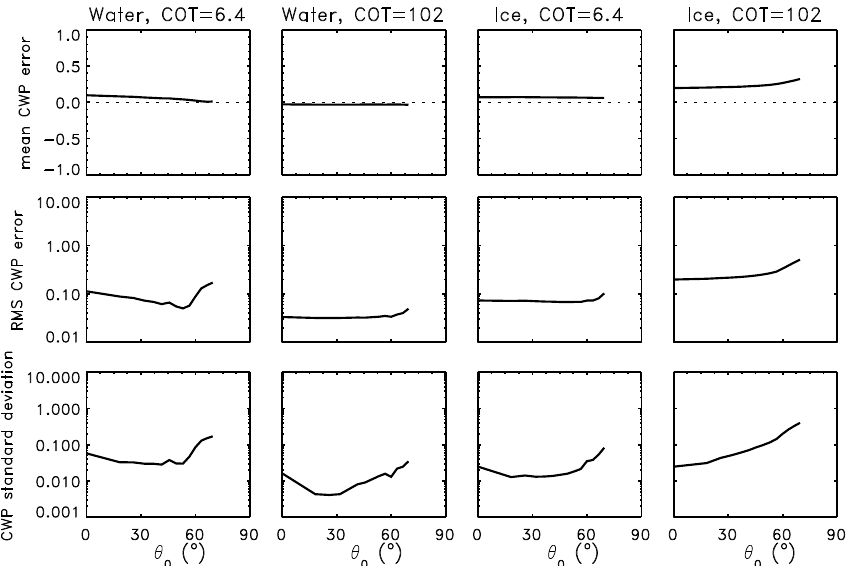
Fig. 4. The CWP retrieval errors as a function of solar zenith angle θ 0 , for different pure liquid water and pure ice clouds (indicated at the top of each column). The top row shows the mean relative error (indicative of the bias of the retrievals); the middle row shows the RMS relative error (indicative of the accuracy of the retrievals); the lower row shows the standard deviation (indicative of the precision of the retrievals). Results were averaged over all satellite geometries with θ < 72 ◦ ; the effective radii are r eff = 11 µ m for liquid water clouds and r eff = 38 µ m for ice clouds.